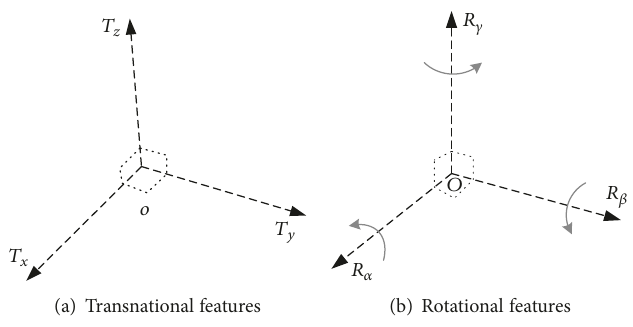
Figure 1: Description for the end-features of the 𝐶